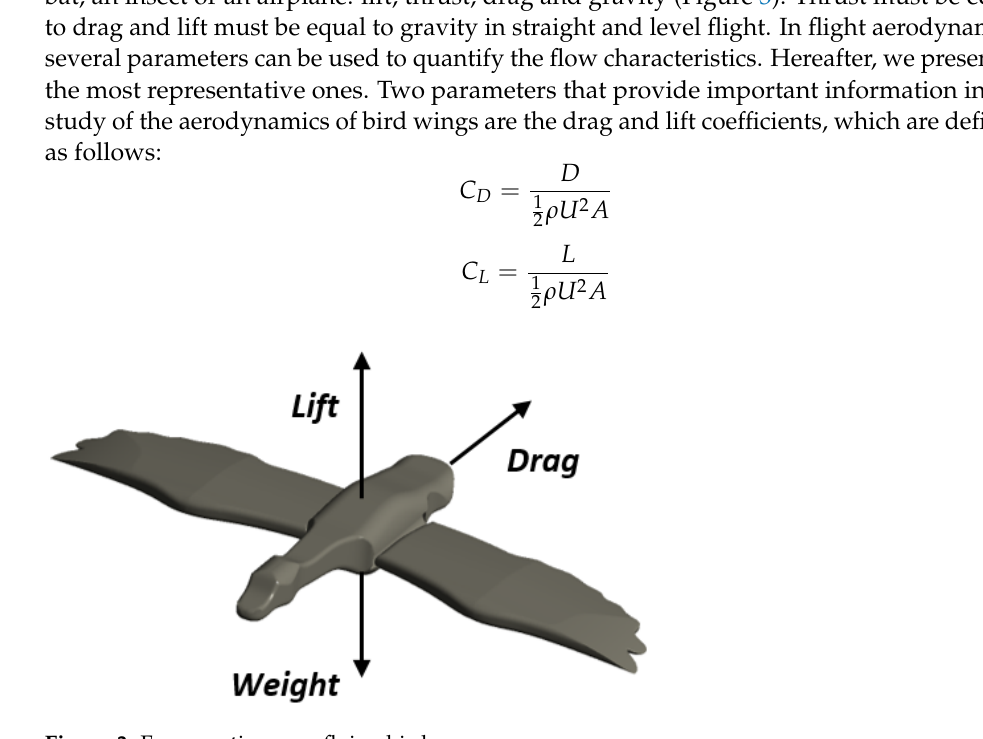
Figure 3. Forces acting on a flying bird.